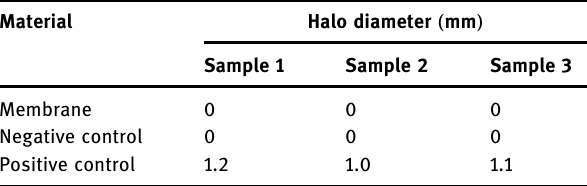
Table 3: Cytotoxicity test